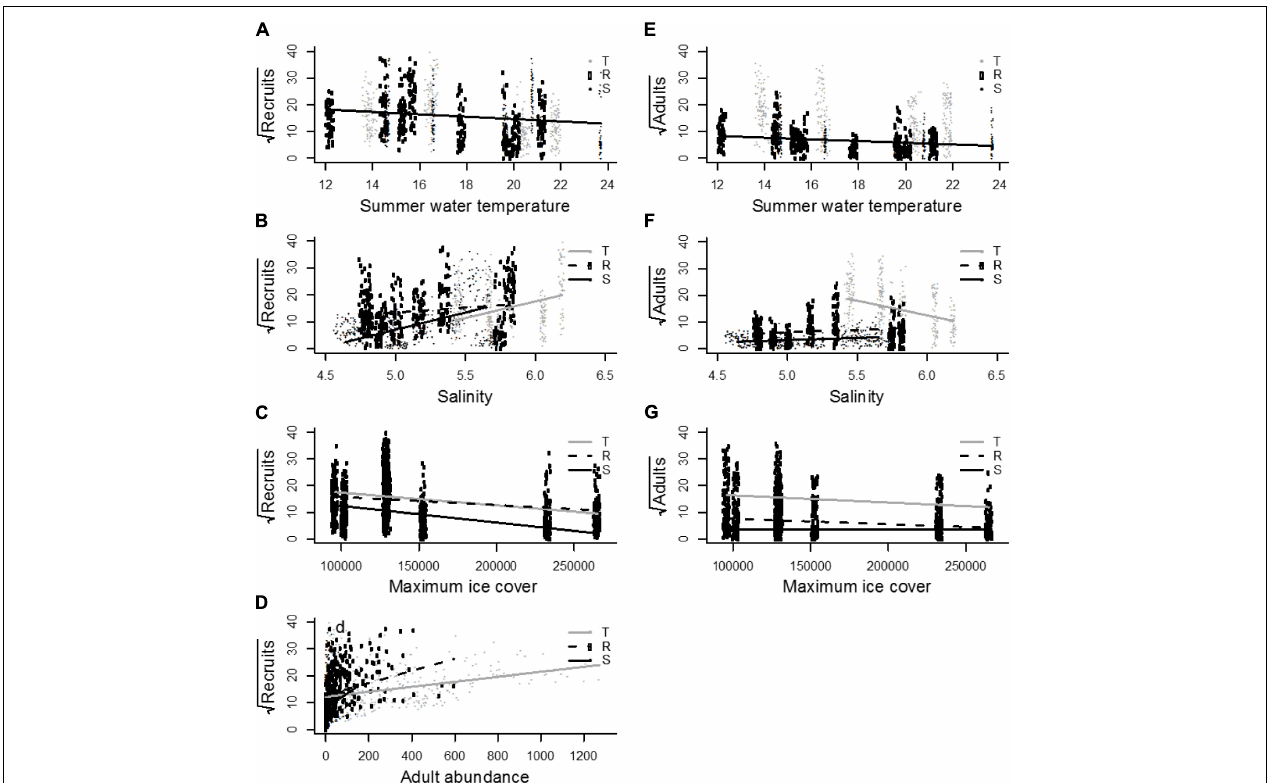
FIGURE 4 | August water temperature had a uniform and negative effect on both recruits (A) and adults (E) . (B) Salinity had a positive effect on the number of recruits in all areas. (C) Severe ice winters (unit is km 2 ) decreased the number of recruits with the strongest effect at Söderskär and affected negatively adults at TV and RÖ, but was insignificant at SÖ (G) . (D) Adult abundance had a positive effect on the number of recruits at all areas with an increase in the strength of this effect from Tvärminne to Söderskär. (F) Salinity had a positive effect on the number of adult mussels at Söderskär and Rönnskär but not at Tvärminne.